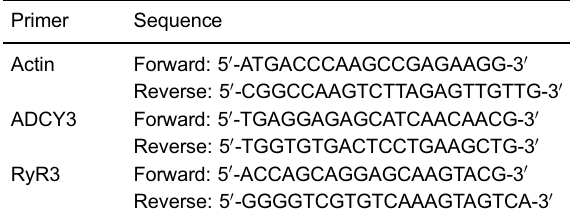
Table 1. Primers used for gene expression